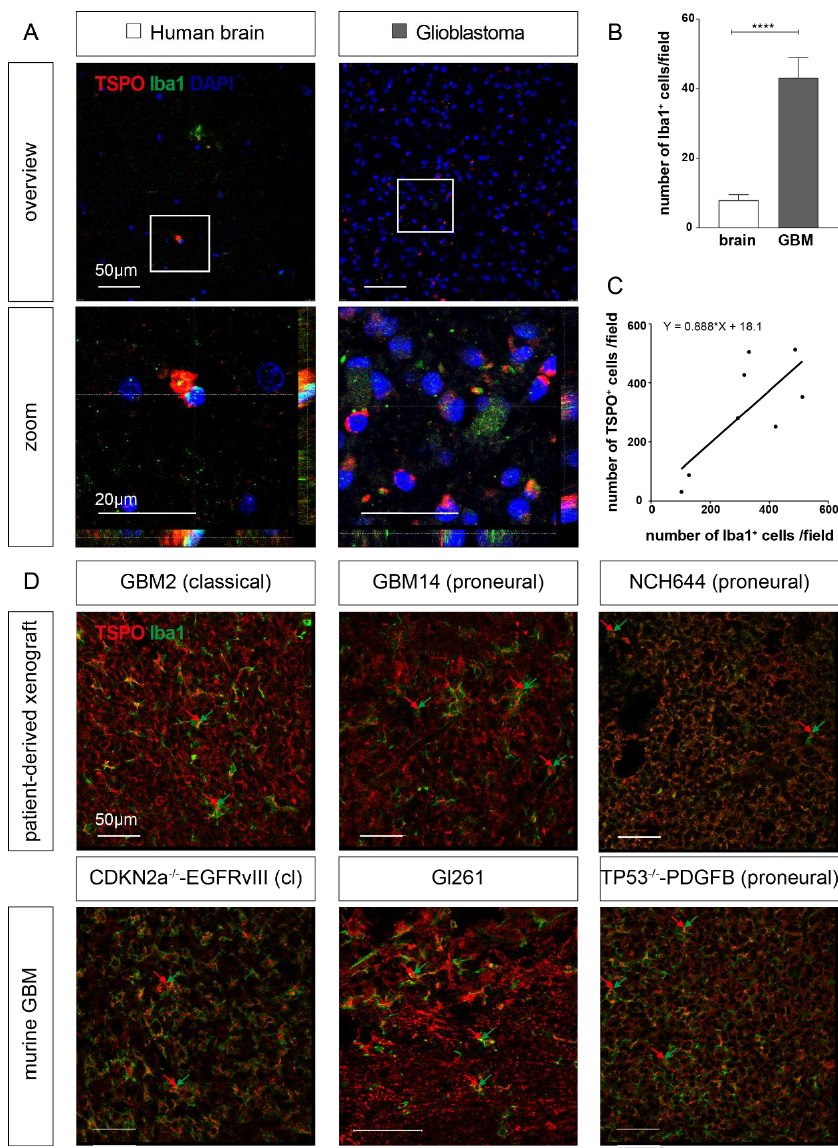
Figure 4. Microglia express TSPO, independent of the genetic GBM subtype. ( A ) Immunofluorescence staining of epilepsy and GBM patients. Co-staining for Iba1 (green) and TSPO (red) indicated the co-expression of both proteins in cells (zoom). ( B ) The number of Iba1-positive cells per field of view at 20x was counted. In the tumor area, significantly more Iba1-positive microglia could be found. The p-value of Student’s t test is indicated as **** p < 0.0001. ( C ) Immunohistochemical analysis of human GBM samples was performed and the number of positive cells was determined. A strong positive correlation between the amount of Iba1-positive cells and TSPO-positive cells was observed ( n = 8). ( D ) Immunofluorescent staining of patient-derived xenografts (PDX) and orthotopic murine GBM implants was performed using anti-Iba1 (green) and anti-TSPO antibodies (red). In all models, TSPO-positive (red) and myeloid (green) cells were detected (arrows). ( A , D ) Scale size is indicated in individual